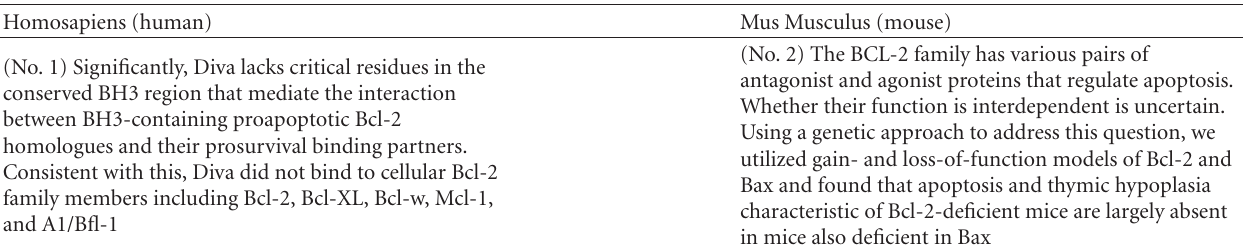
Table 3: A sample text from species disambiguation.